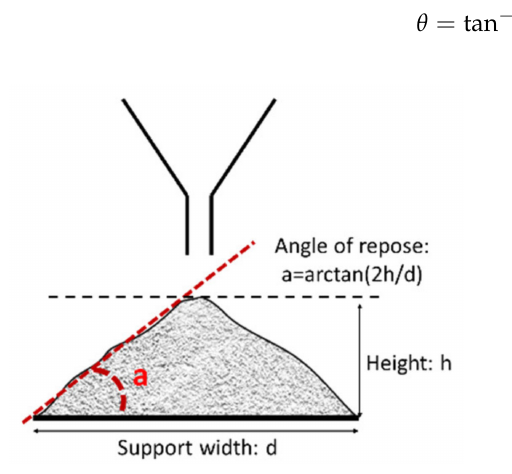
Figure 1. Scheme of angle of repose measurement of